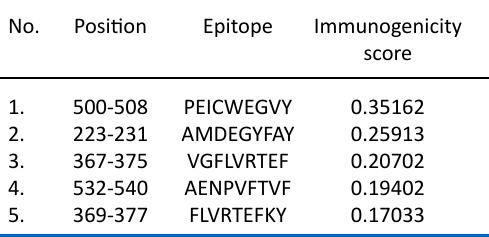
Table 1. MHC-I immunogenicity scores for